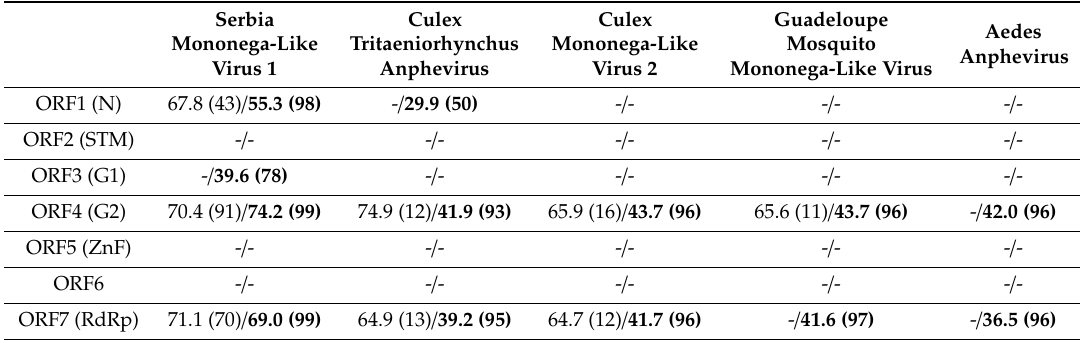
Bold values: amino acid identity; non bolded values: nucleotide identity. Values in parentheses correspond to the percentage of query coverage. “-” indicates no detected similarity. Values of alignments below 10% of query coverage are not reported. Serbia mononega-like virus 1, accession number MT822181.1; Culex tritaeniorhynchus Anphevirus, accession number LC514054.1; Culex mononega-like virus 2, accession number MF176332.1; Guadeloupe